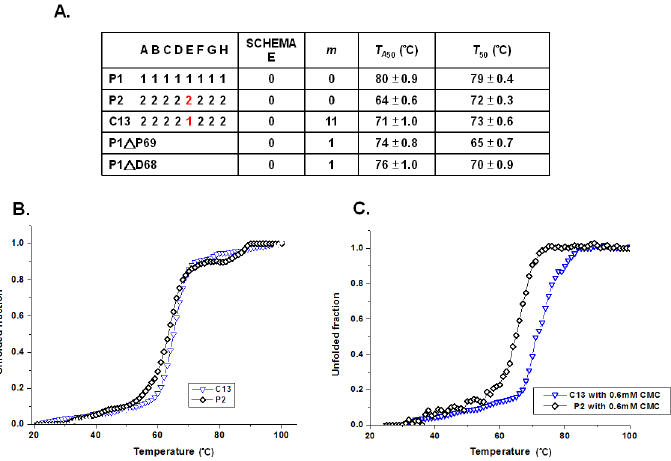
Fig 4. Profile of SCHEMA block E of GsCelA. (A) Thermostabilities of parent enzymes, chimeras and mutants are highlighted for block E. (B) Thermal denaturation curves of P2 (without E loop) and C13 (P2 with additional E loop). (C) Thermal denaturation curves of P2 and C13 in the presence of 0.6 mM CMC (1%